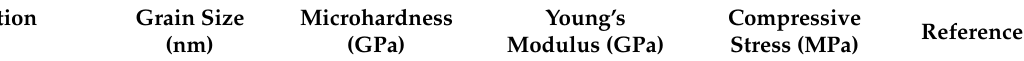
Table 4. Grain size and mechanical properties of the Ti-Al